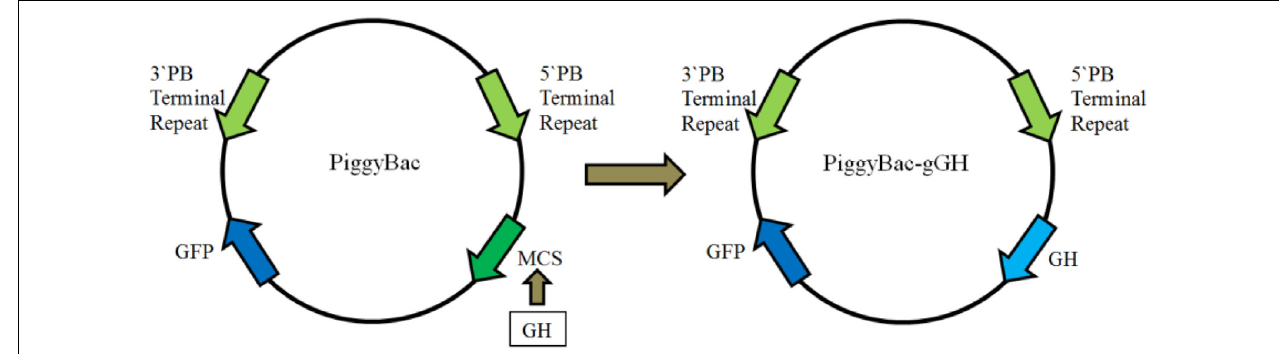
FIGURE 2 | Construction of plasmid piggyBac-gGH. The left is the plasmid PiggyBac , the right the recombinant plasmid piggyBac-gGH . PB, piggyBac ; GFP, green fluorescent protein; MCS, multiple clone sites; gGH, growth hormone gene of orange-spotted